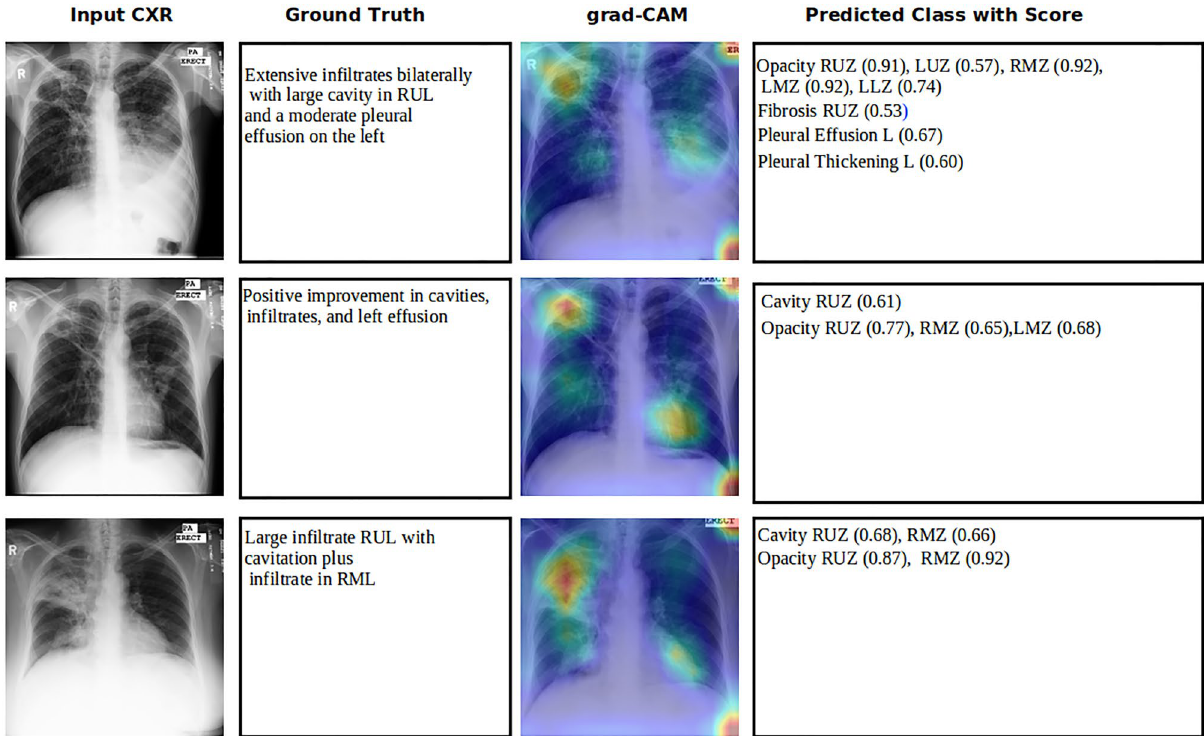
Figure 5. Grad-CAM image overlaid with Tuberculosis patients in external test set. Panel (input CXR) shows the chest X-ray images of patients. Panel (ground truth) shows the clinical readings associated with CXR. Panel (grad-CAM) shows the gradient-weighted class activation map overlaid with input CXR image. Panel (predicted class with score) shows the abnormality prediction with class score 0 to 1. RUZ right upper zone, RMZ right mid zone, LUZ left upper zone, LMZ left mid zone, LLZ left lower zone, L left predicted with score of 0.67 and in addition, right upper zone fibrotic scars (0.53) and pleural thickening on left lung (0.60) were also predicted. Heat map analysis revealed cavity in RUL, bilateral infiltration which are aligned with ground truth. Right lung blunted costophrenic angle showed up in heatmap which was over estimated as confirmed with radiologist. Second row in Fig. 5 is repeated (unknown duration) image of the same patient in first row sample with ground truth uncovering pathological improvements in cavities, infiltrations and left effusion. Network predic- tion aligned with clinical findings. Heatmap analysis reviewed by radiologist expressed cavity in RUZ prediction aligned with heatmap and coarse estimation of opacity in RUZ, RMZ and LMZ. Heat generated near left ventricle and left atrium are declared as noise. Figure 5 third row sample shows chest X-ray of 63 years old female with active cavitary TB. Findings show large infiltration with cavitation in right upper lobe and signs of infiltration in right middle lobe. The algorithm prediction aligned with ground truth with cavity in RUZ and RMZ (scores of 0.68 and 0.66 respectively) and opacity in RUZ and RMZ (scores of 0.87 and 0.92 respectively). Grad cam heatmap verified by radiologist stressed that heat spread to left lung is noise and heatmap pointed to the cavitational area. It is also noted that the spread